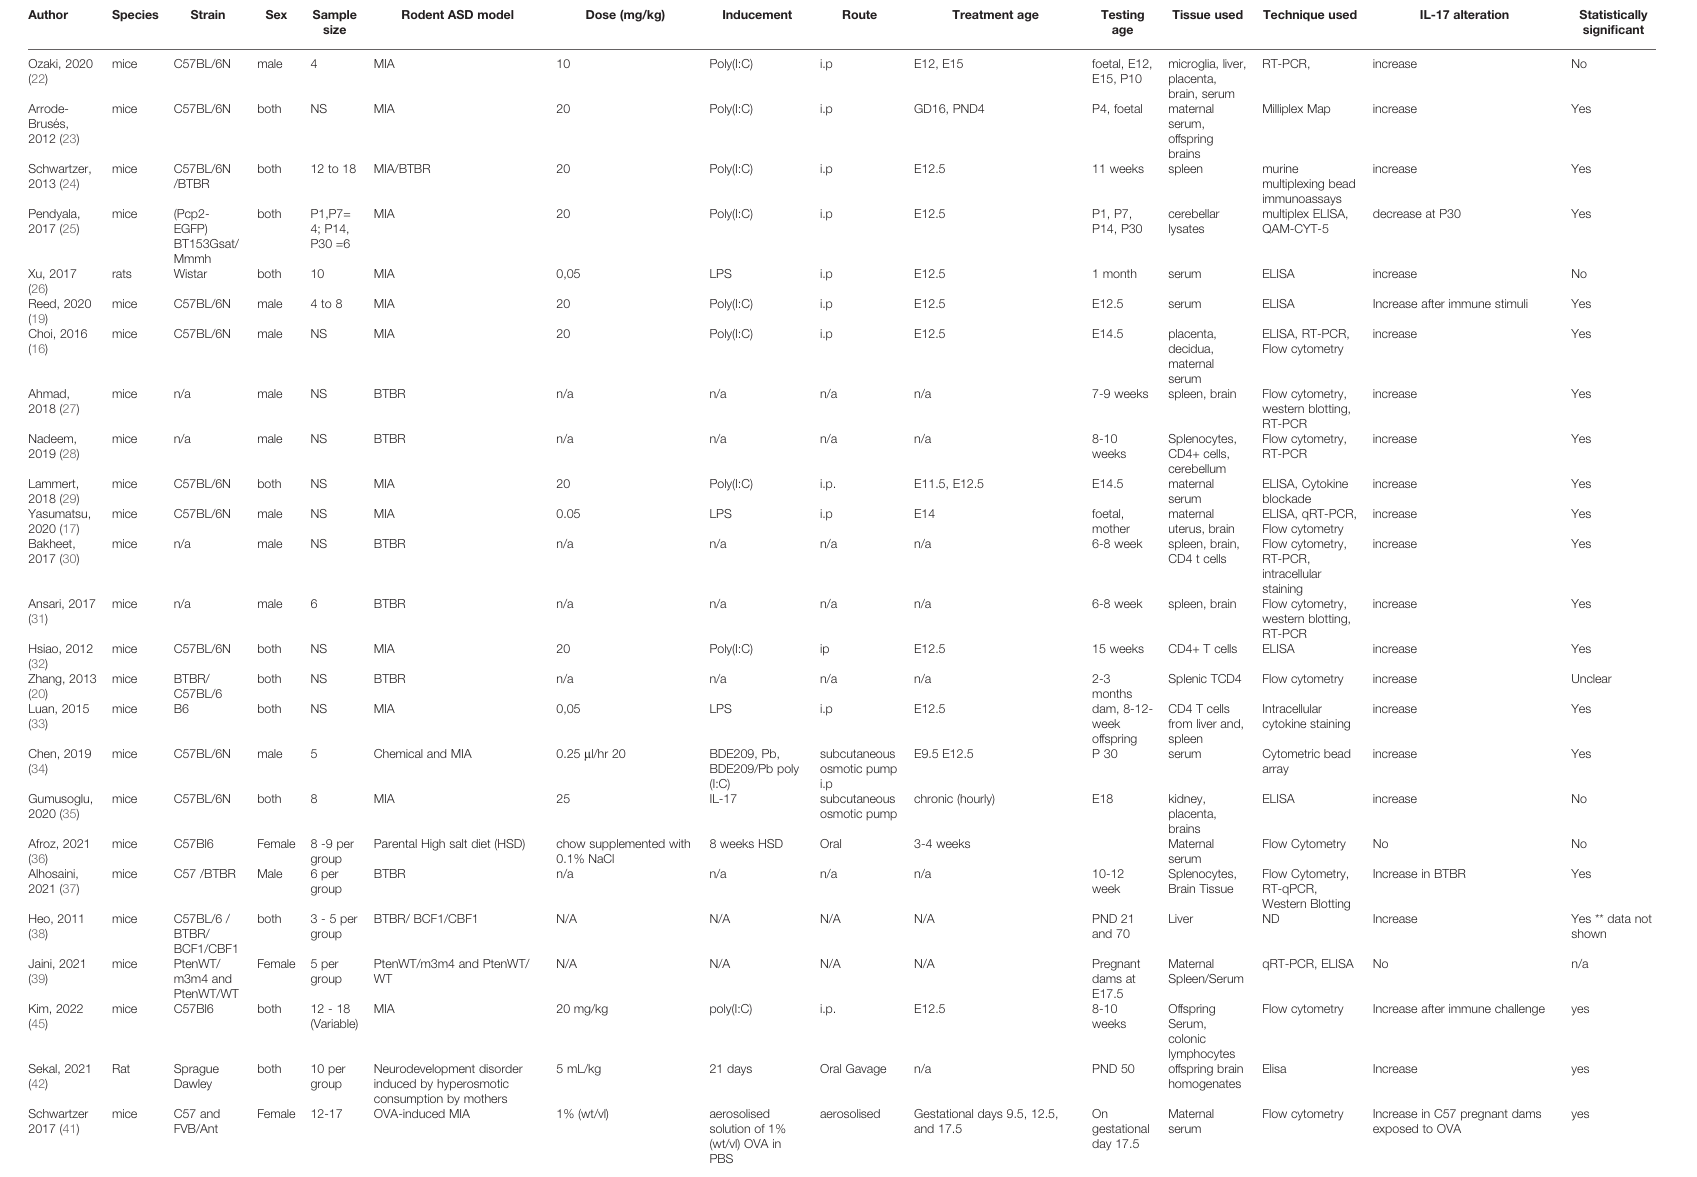
TABLE 3 | Qualitative synthesis of studies